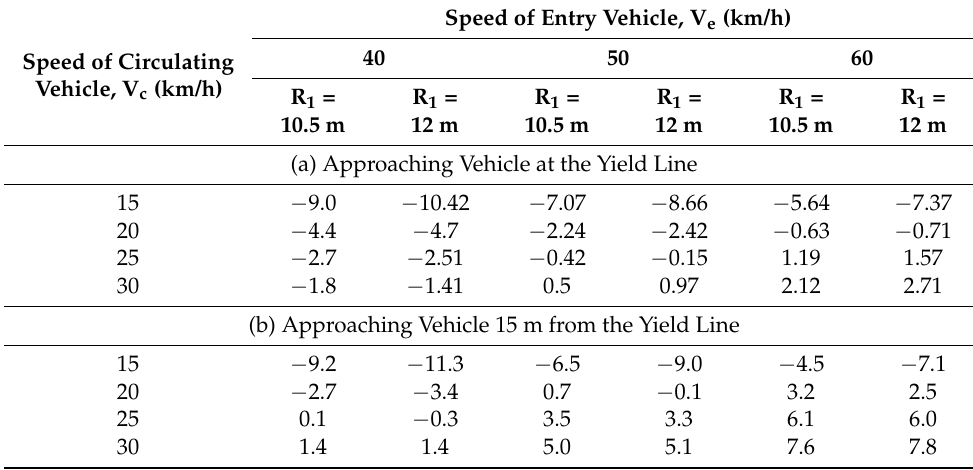
Table 4. Lateral clearance C f 2 (m) for conflicting-entering vehicle (Approach 1).